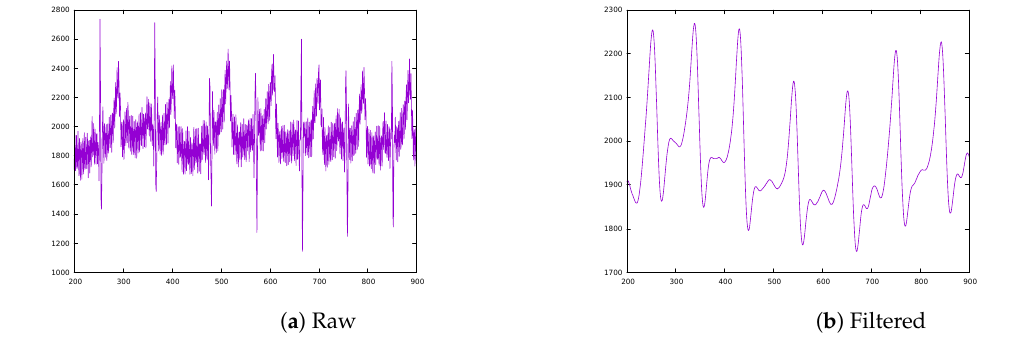
Figure 8. Raw vs. filtered ECGs from the AD8232.